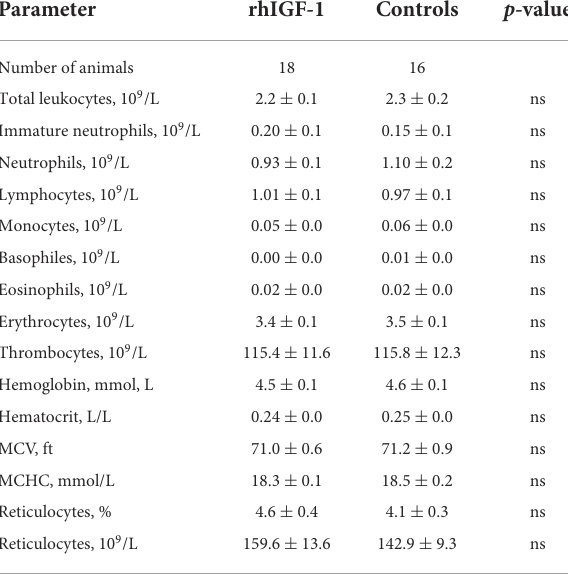
TABLE 4 Hematology of preterm pigs treated with rhIGF-1 or vehicle formulation, continuous intra-arterially for 4 days in Experiment 2. Parameter rhIGF-1 Controls p-